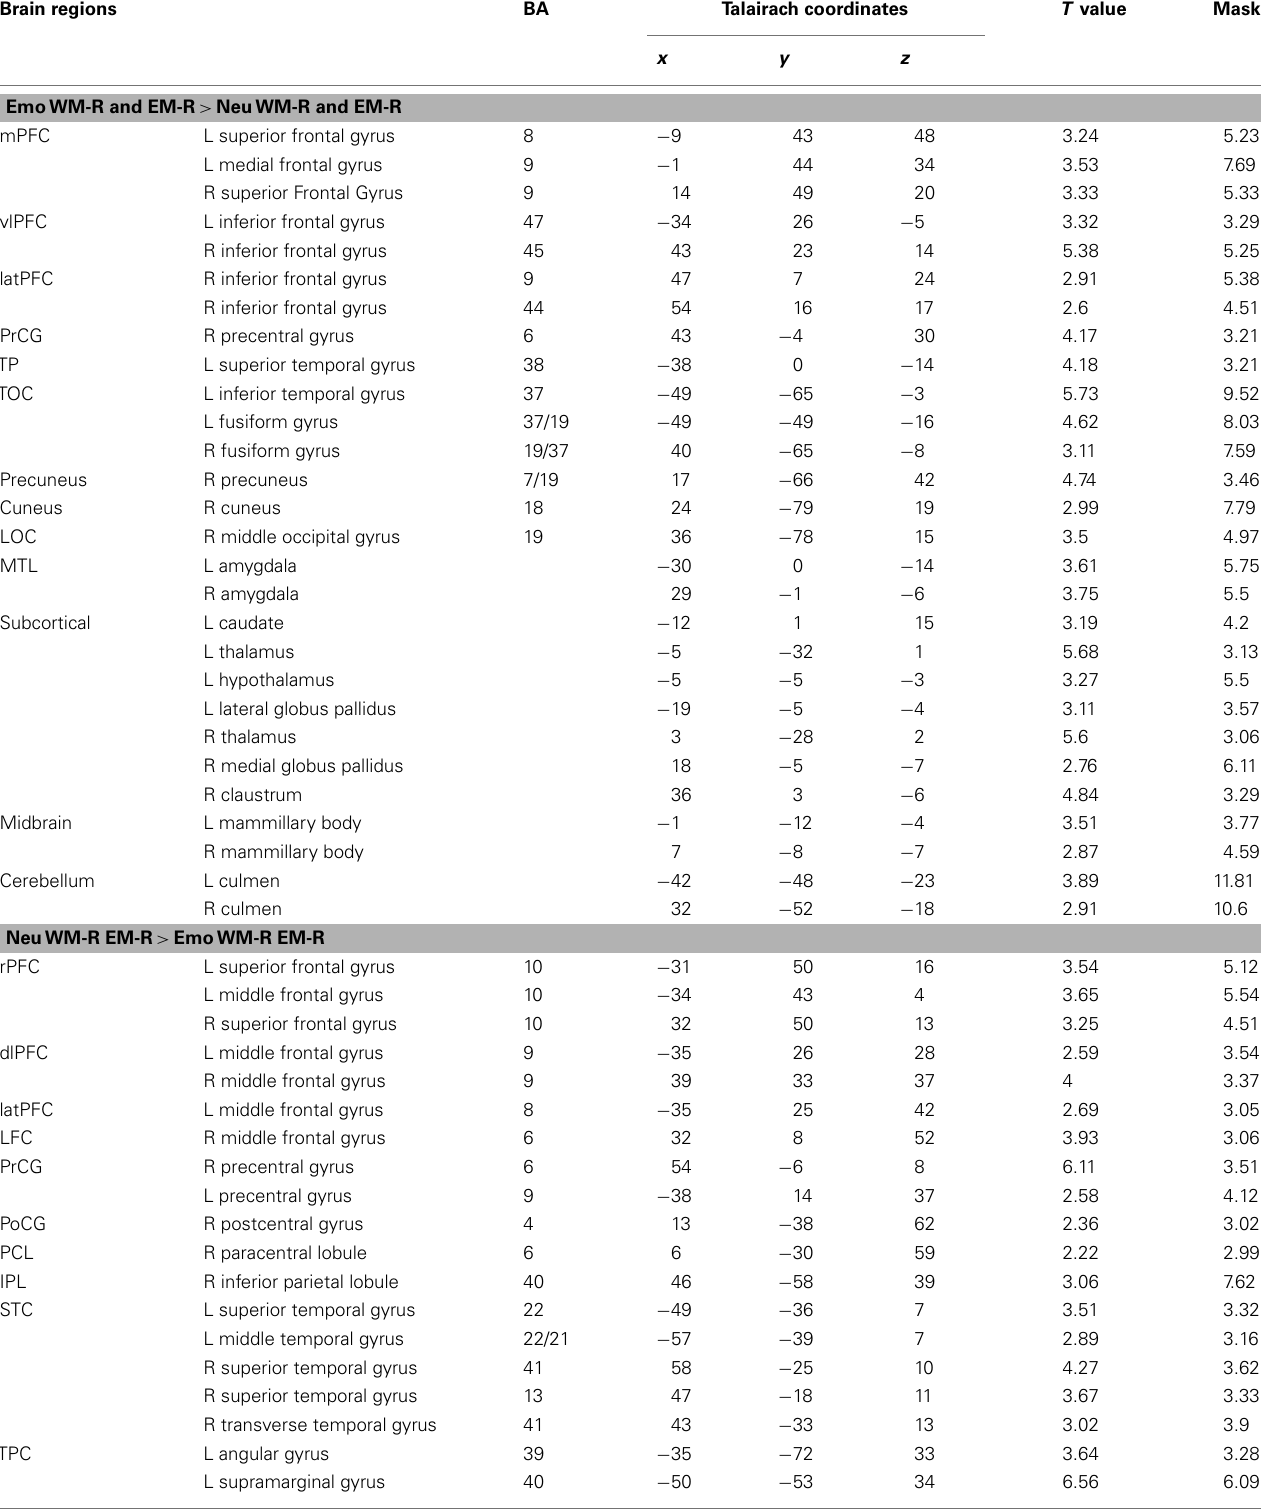
Table 2 | Differential effects in the ventral and dorsal neural systems linked to successful coping with emotional distraction and enhanced EM for the distracters